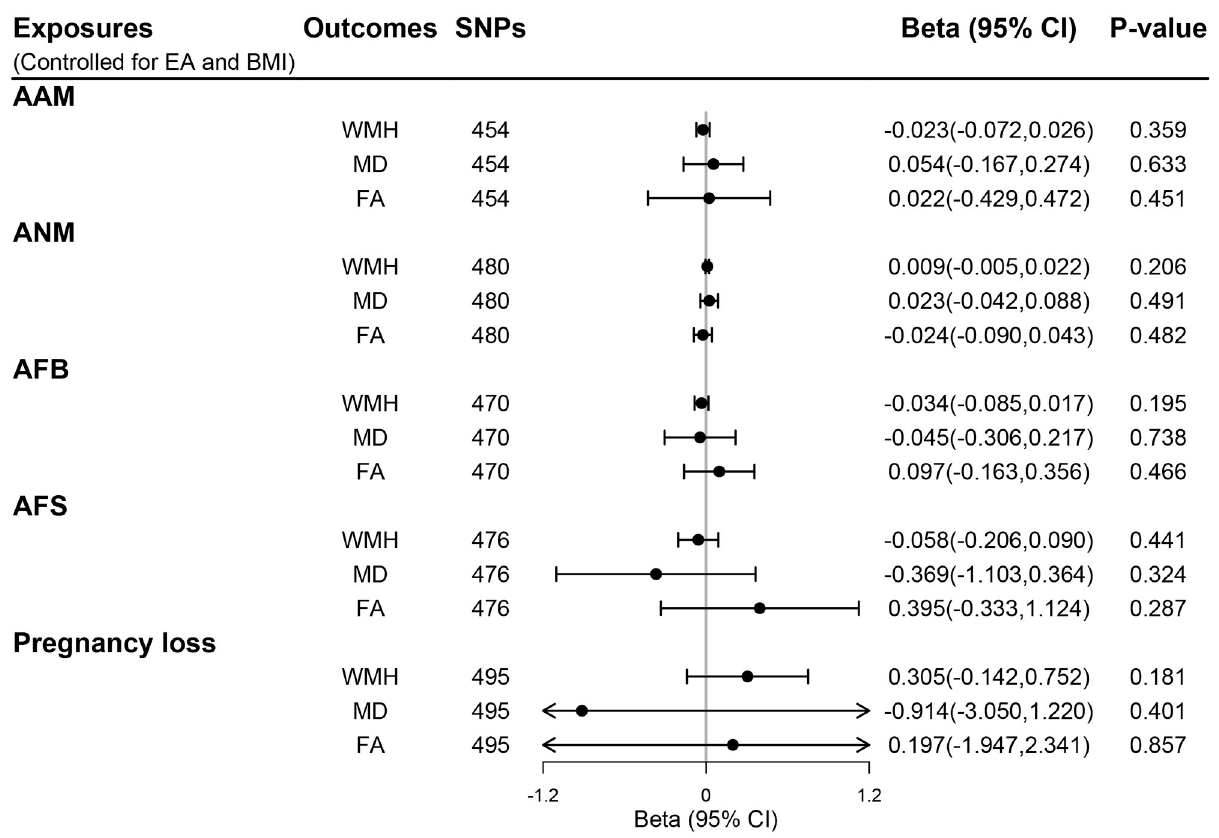
FIGURE5 The direct effect of genetically determined women’s reproductive traits on MRI markers of CSVD using MVMR controlled for EA and BMI. AAM, age at menarche; AFB, age at first birth; AFS, age at first sexual intercourse; ANM, age at natural menopause; BMI, body mass index; EA, educational attainment; FA, fractional anisotropy; MD, mean diffusivity; WMH, white matter